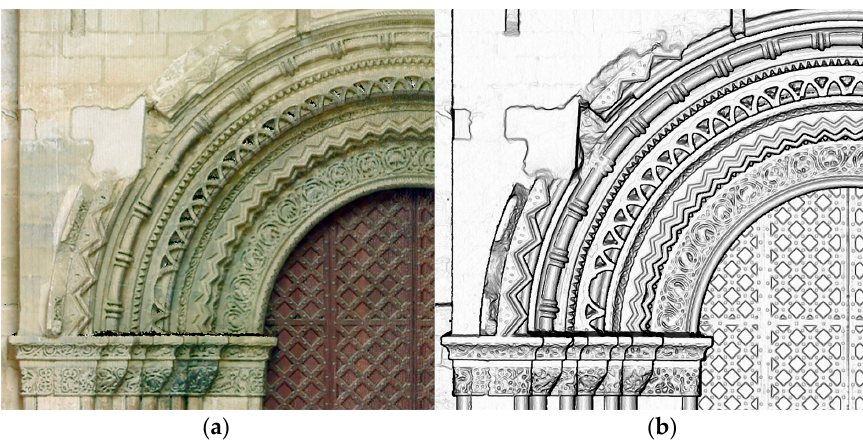
Figure 7. Identification of previous interventions with different materials: ( a ) identification of alterations in geometric patterns and ( b ) slope raster obtained through DEM spatial analysis.